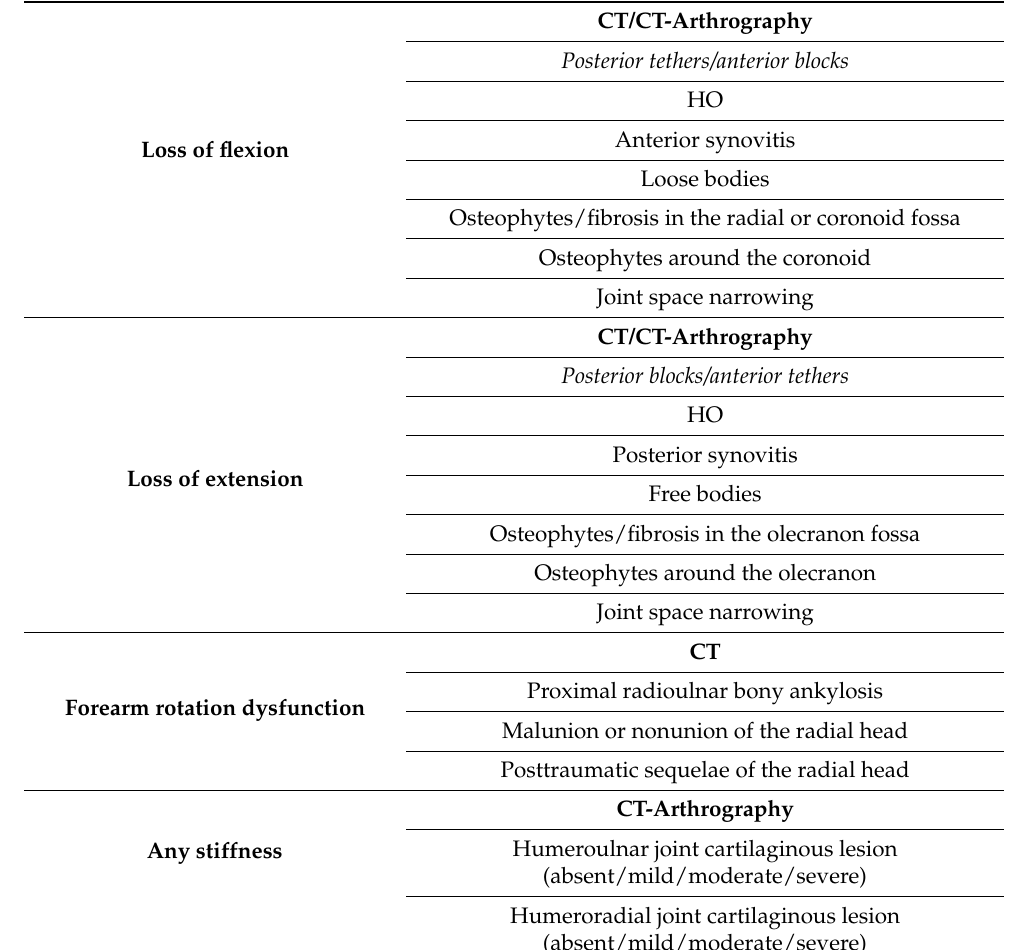
Table 4. CT and CT-arthrography